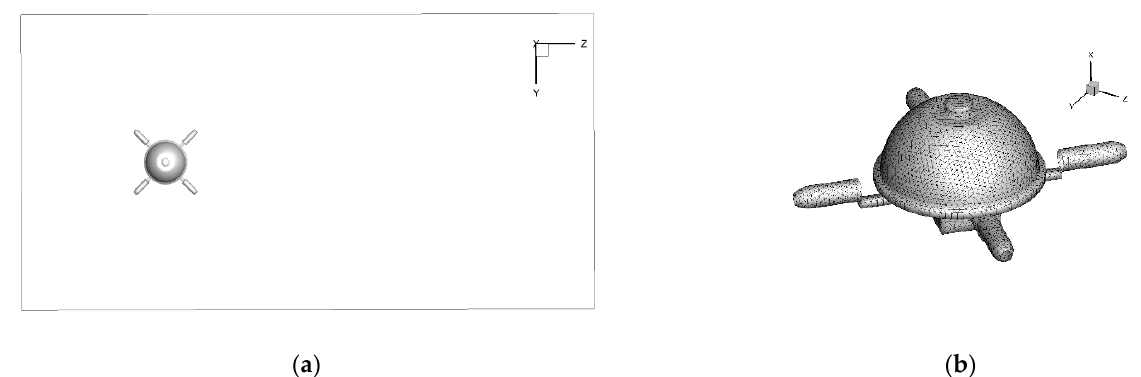
Figure 2. The computational fluid dynamic model used to simulate the actual physics experiments based on the immersed boundary-lattice Boltzmann method (IB-LBM). ( a ) The computational domain; ( b ) The simplified model of the robot.